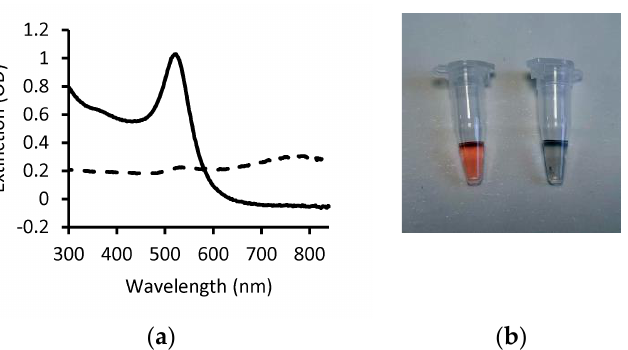
Figure 3. Change in AuNP optical properties due to aggregation. ( a ) Extinction spectra of dispersed 20 nm citrate-capped AuNPs (solid line) and of the same solution after adding NaCl (dashed line). The presence of charged ions destabilizes the colloid via screening of negative charges with consequent aggregation and loss of the SPR band. ( b ) Photograph of the AuNP solutions from panel a (dispersed, left; aggregated, right).